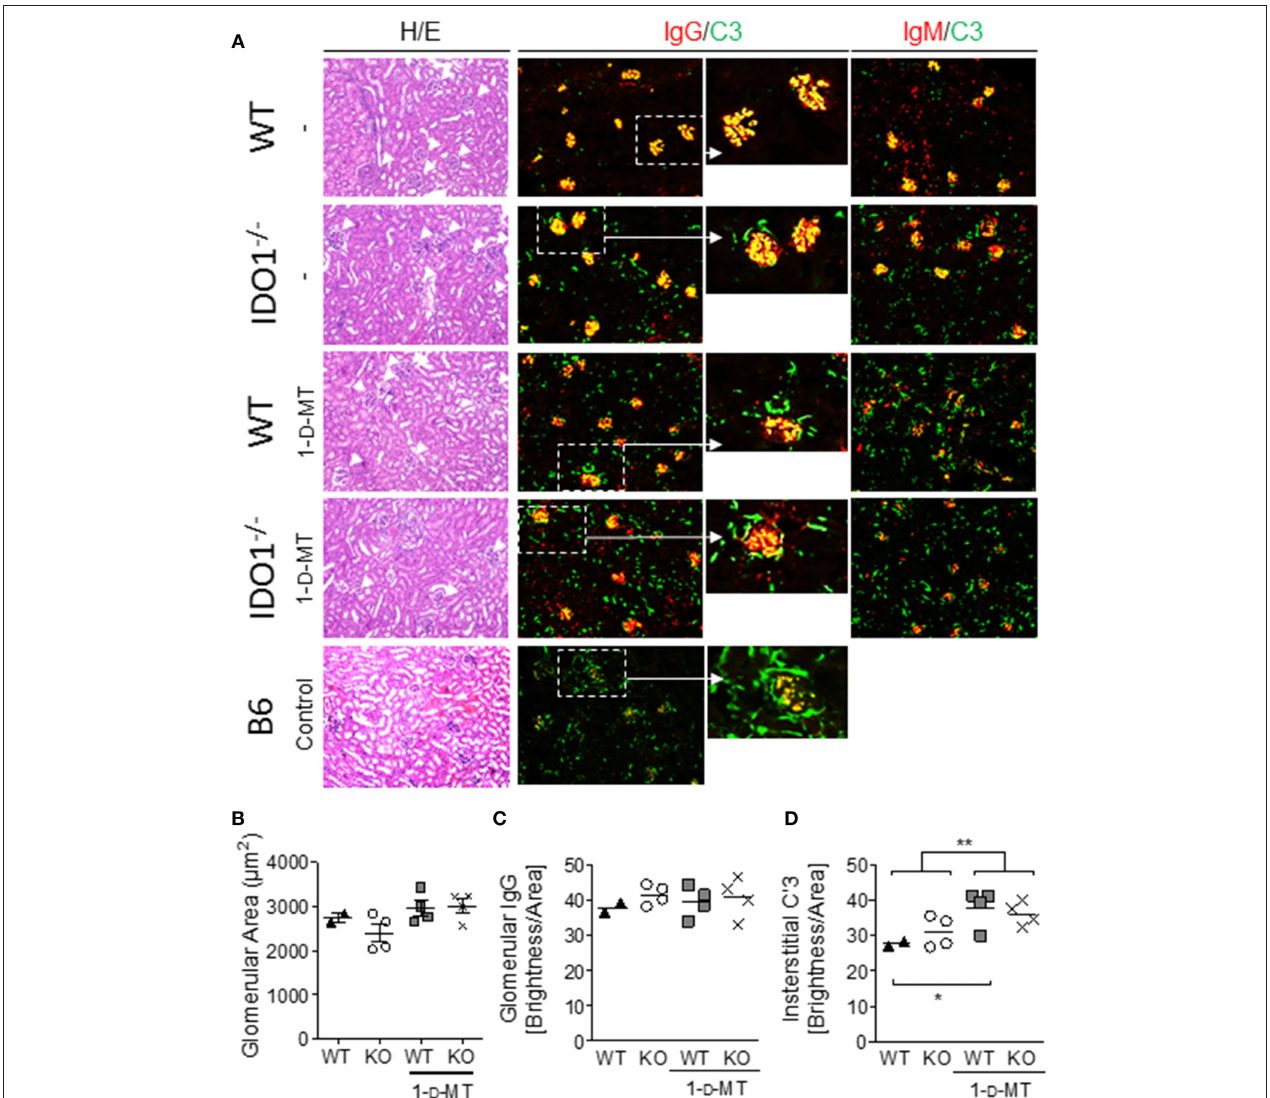
FIGURE 3 | 1- D -MT treatment does not affect renal inflammation but reduces complement factor C’3 fixation in kidney glomeruli. Kidneys were harvested from 16 week old IDO1-deficient and -sufficient B6.Nba2 mice treated with PBS or 1- D -MT and from female age-matched B6 control mice. Hematoxylin/eosin staining showed no significant differences in glomerulonephritis and mesangial proliferation (A,B) . Staining for IgG, and IgM showed no measurable differences in glomerular IgG and IgM brightness levels between B6.Nba2 mice ( C and not shown) but a significant increase in interstitial C’3 brightness levels in 1- D -MT treated B6.Nba2 mice (**) (A,D) . Each symbol represents one mouse. * p < 0.05; ** p < 0.01; Student’s unpaired t -test with Welch’s